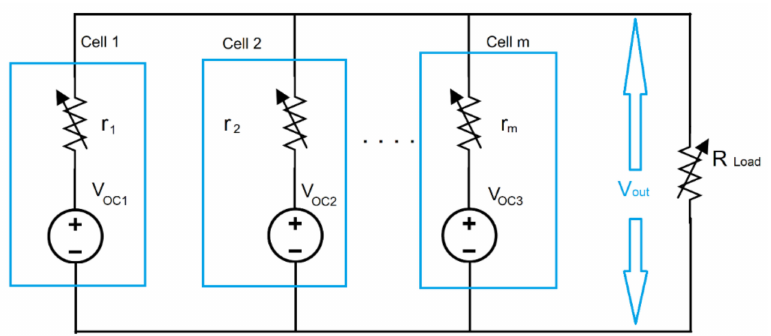
Figure 8. Equivalent simplified circuit of parallel DC cells connected to a common variable load.